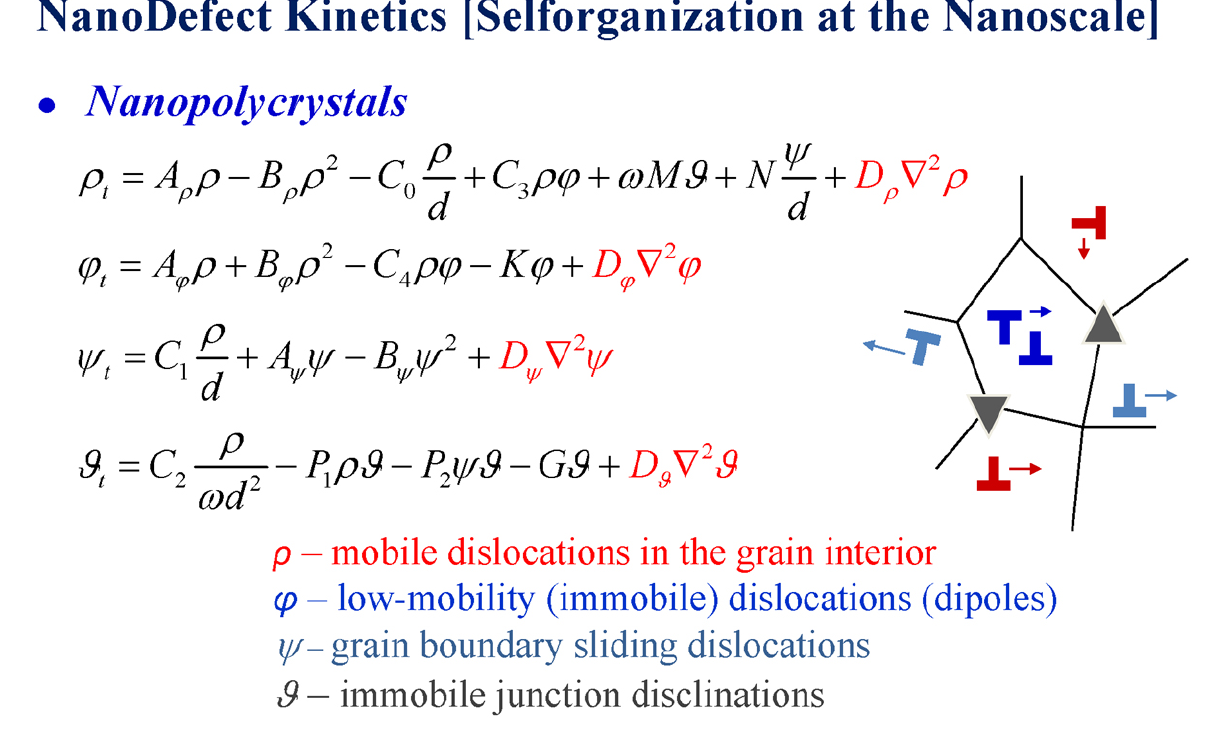
Figure 3: Reaction-Diffusion (R-D) type equations for the dominant families of structural defects in